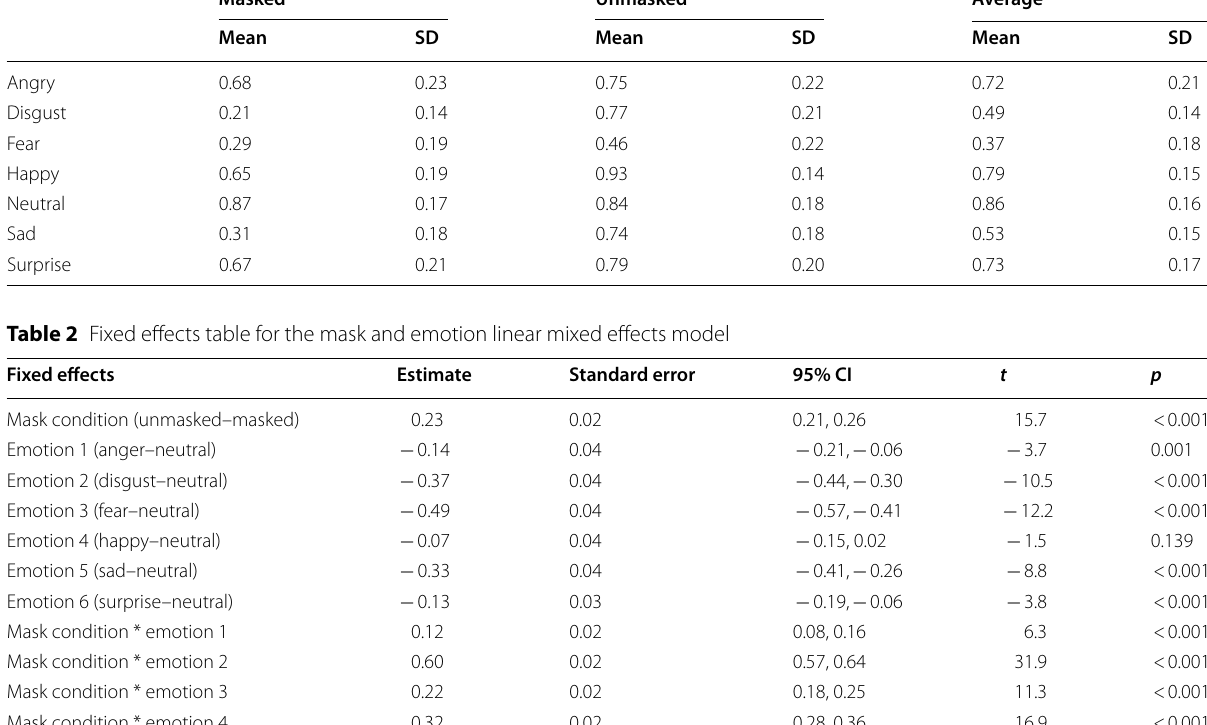
Table 1 Mean and SD emotion accuracy (proportion correct) for each emotion, masked and unmasked Masked